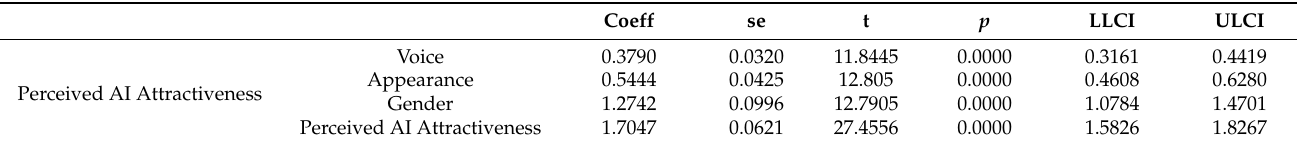
Table 2. Fit result of the mediating effect.